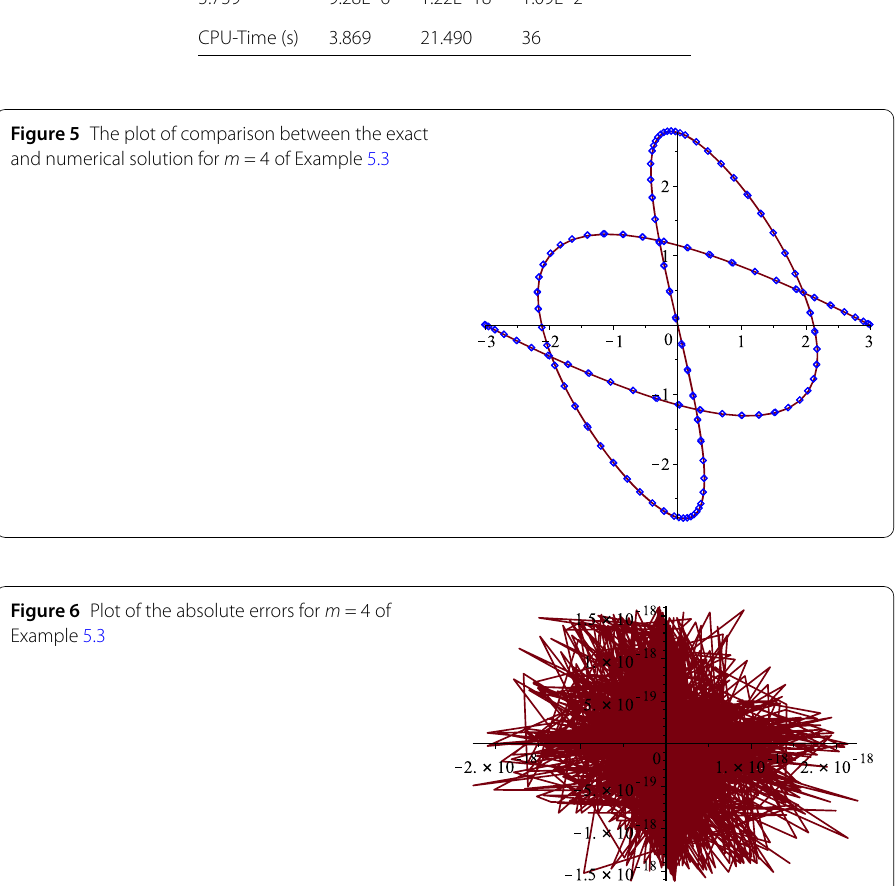
Figure 5 The plot of comparison between the exact and numerical solution for m = 4 of Example 5.3